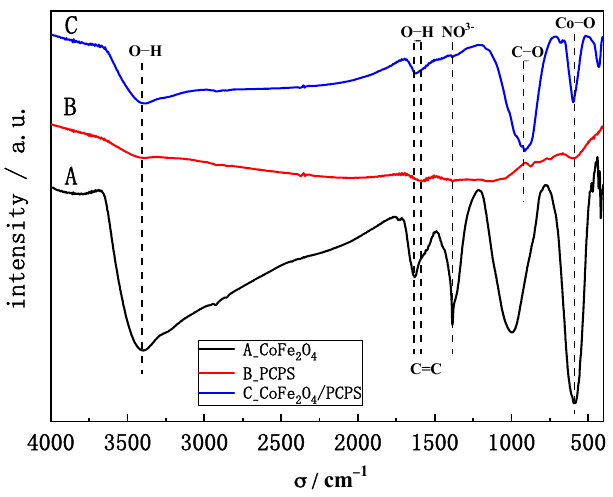
Figure 4. FTIR spectra for synthesized CoFe 2 O 4 ( A ), PCPS ( B ), and CoFe 2 O 4 /PCPS ( C ). The band at approximately 3405 cm − 1 represented the O-H stretching vibration [21] and is shown in Figure 4A–C. The bands at 1635 cm − 1 , 1384 cm − 1 , and 400–650 cm − 1 were assigned to the O-H, NO 3 − , Fe-O, and Co-O groups [22], respectively. These